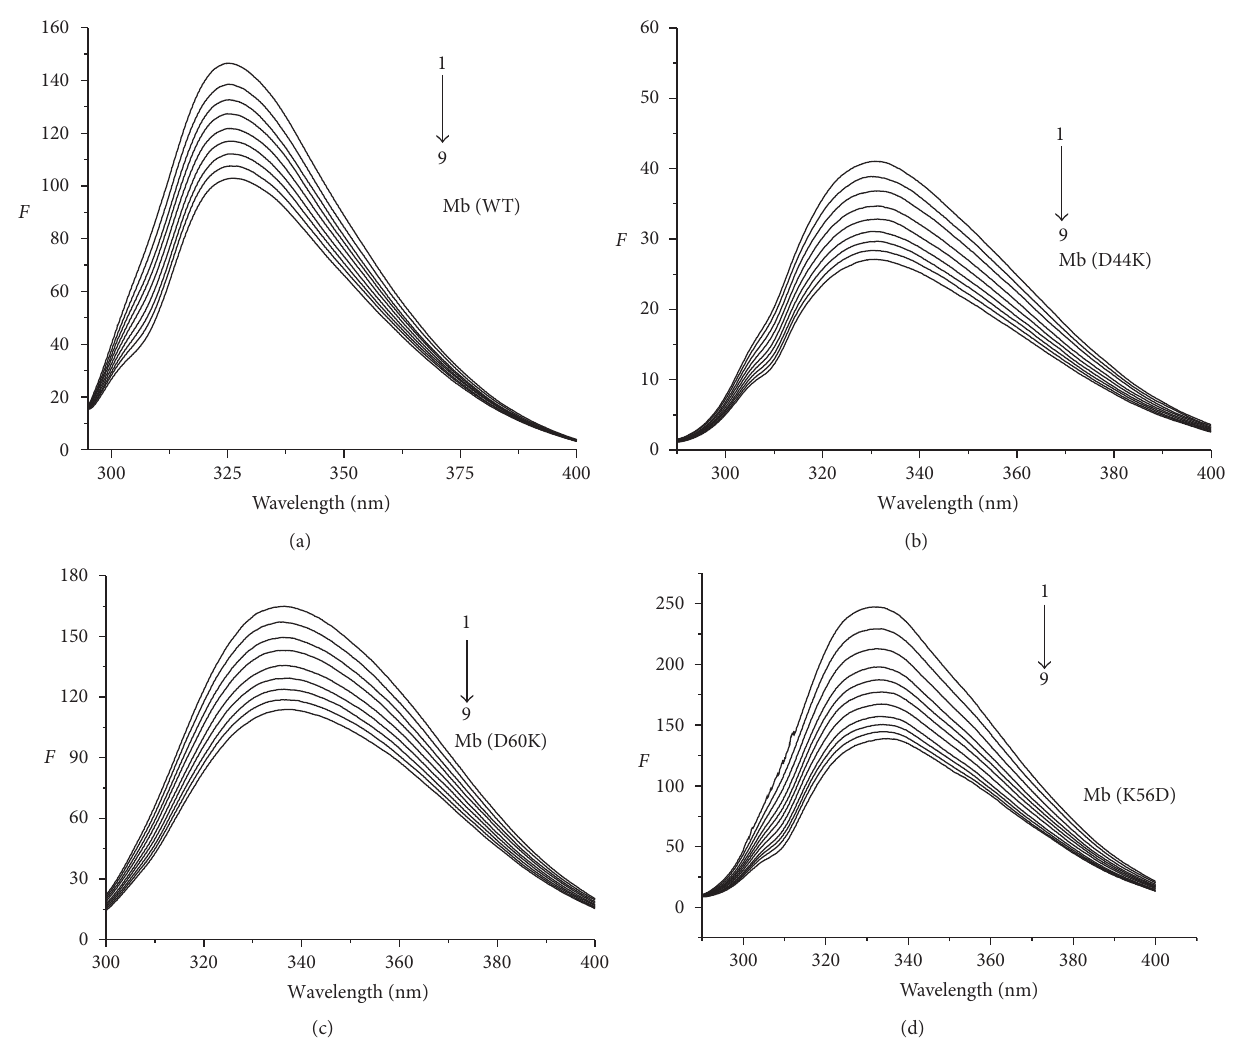
F 2: �ffect of Fe(III) on the �uorescence spectra of Mbs